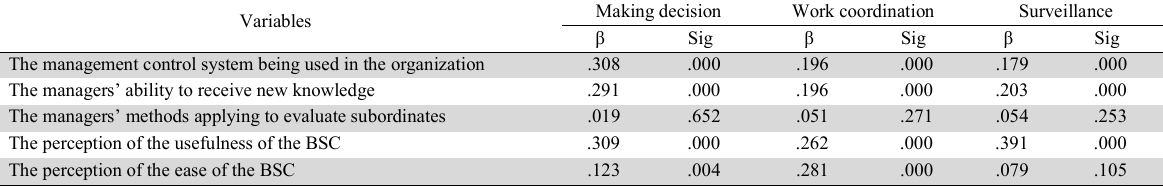
Making decision Work coordination